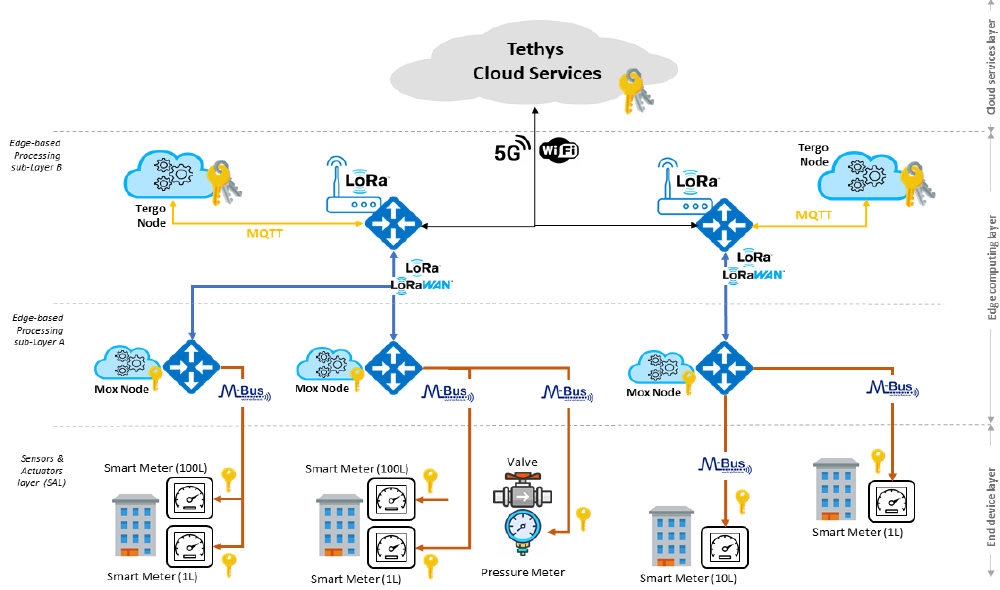
Figure 4. The fog computing-based data